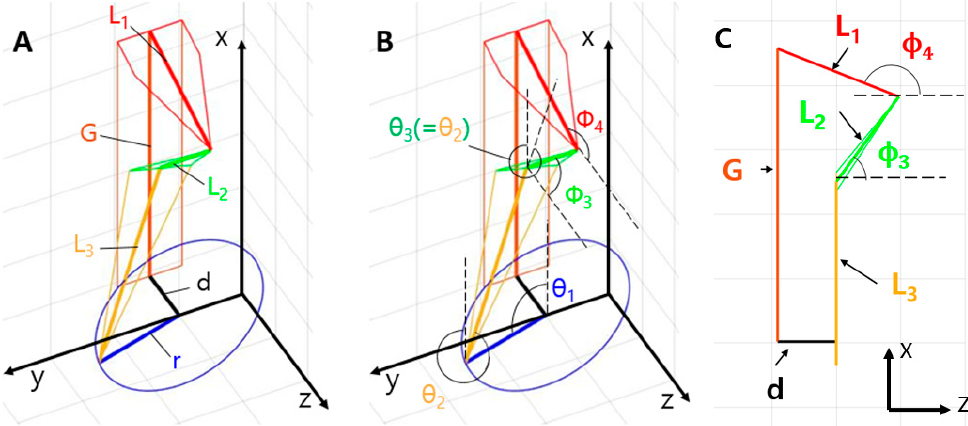
Figure 6. The vector loop of the constrained spherical six ‐ bar transmission for the kinematic analysis. Diagonal view ( A , B ) and x ‐ z plane view ( C ).